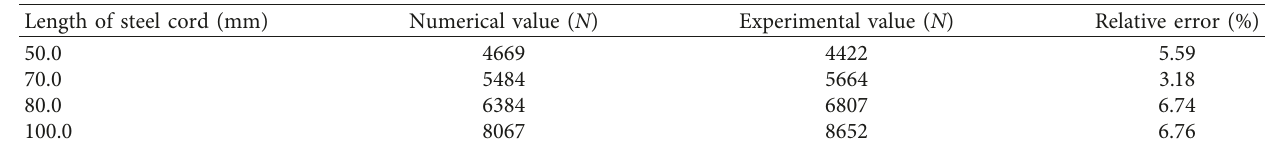
Figure 6: Simulation and experimental results. (a) Numerical results. (b) Experimental results. Table 1: Simulation and experimental data.